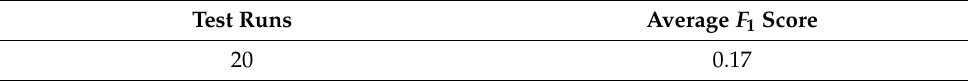
Table 7. ISFB Similarity Using OpenSSL Features.